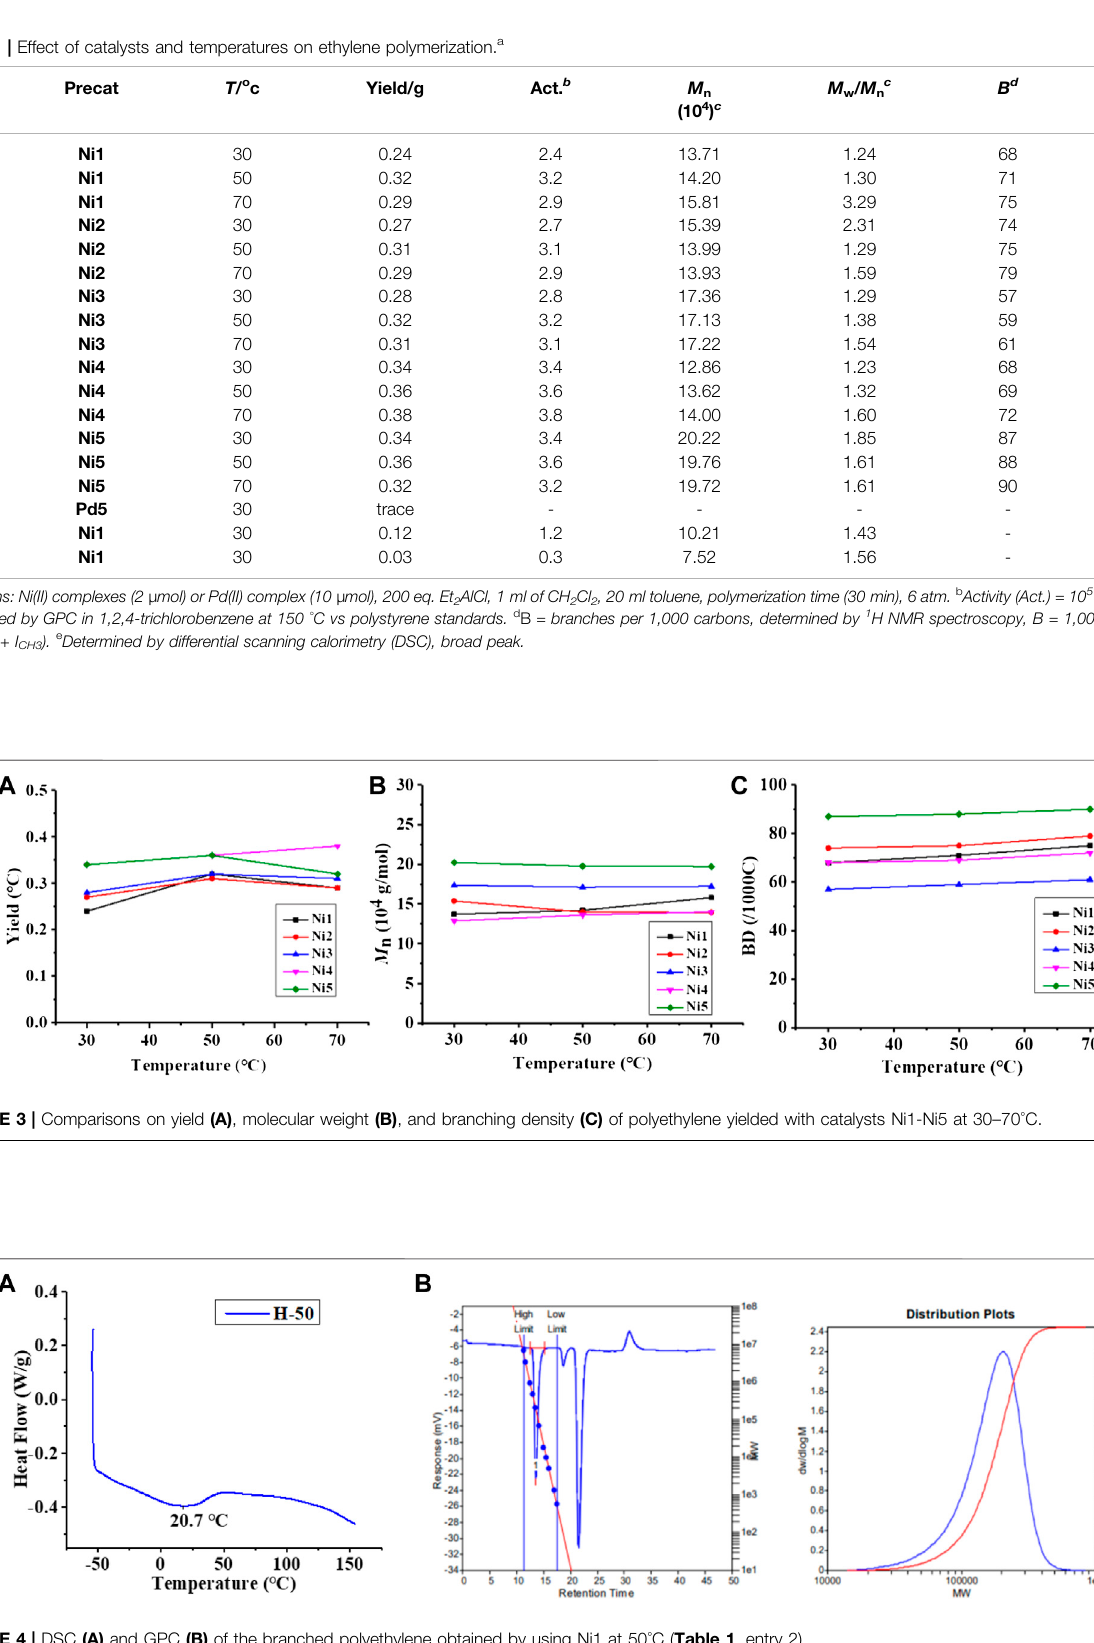
FIGURE 4 | DSC (A) and GPC (B) of the branched polyethylene obtained by using Ni1 at 50 ° C ( Table 1 , entry 2).